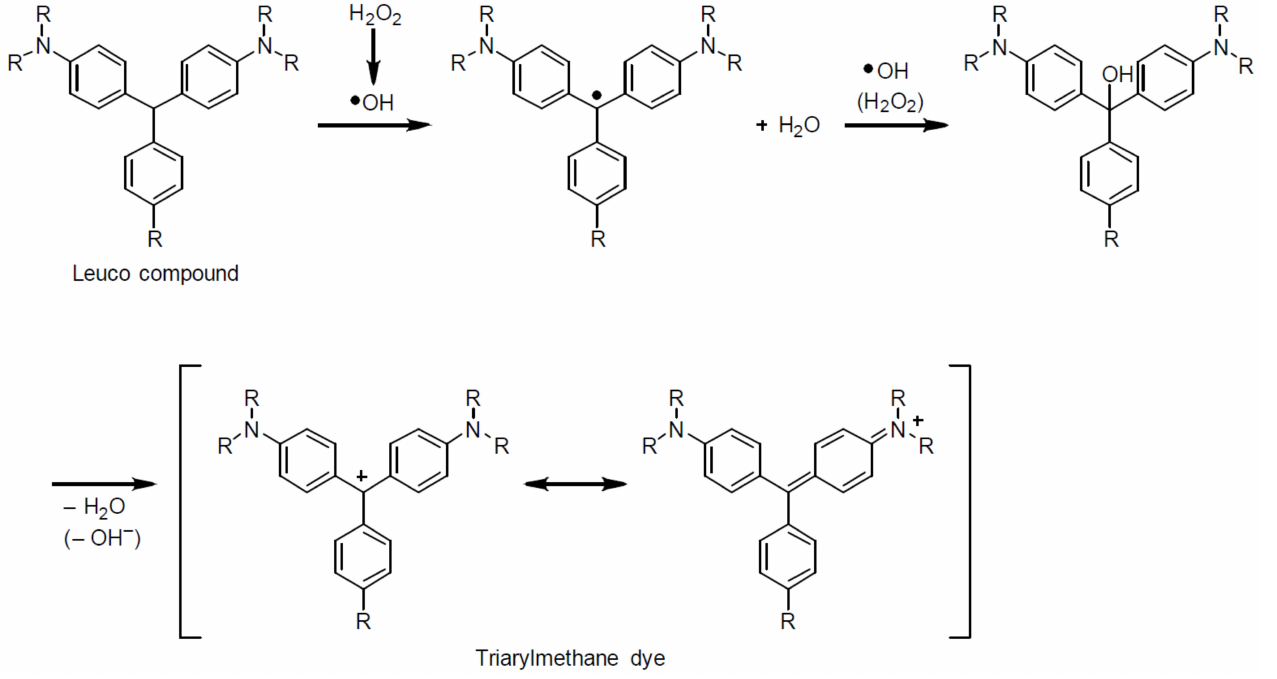
Figure S1: 1H-NMR of purchased and purified Acid Blue 7 (Alphazurine A), Figure S2: 1H-NMR